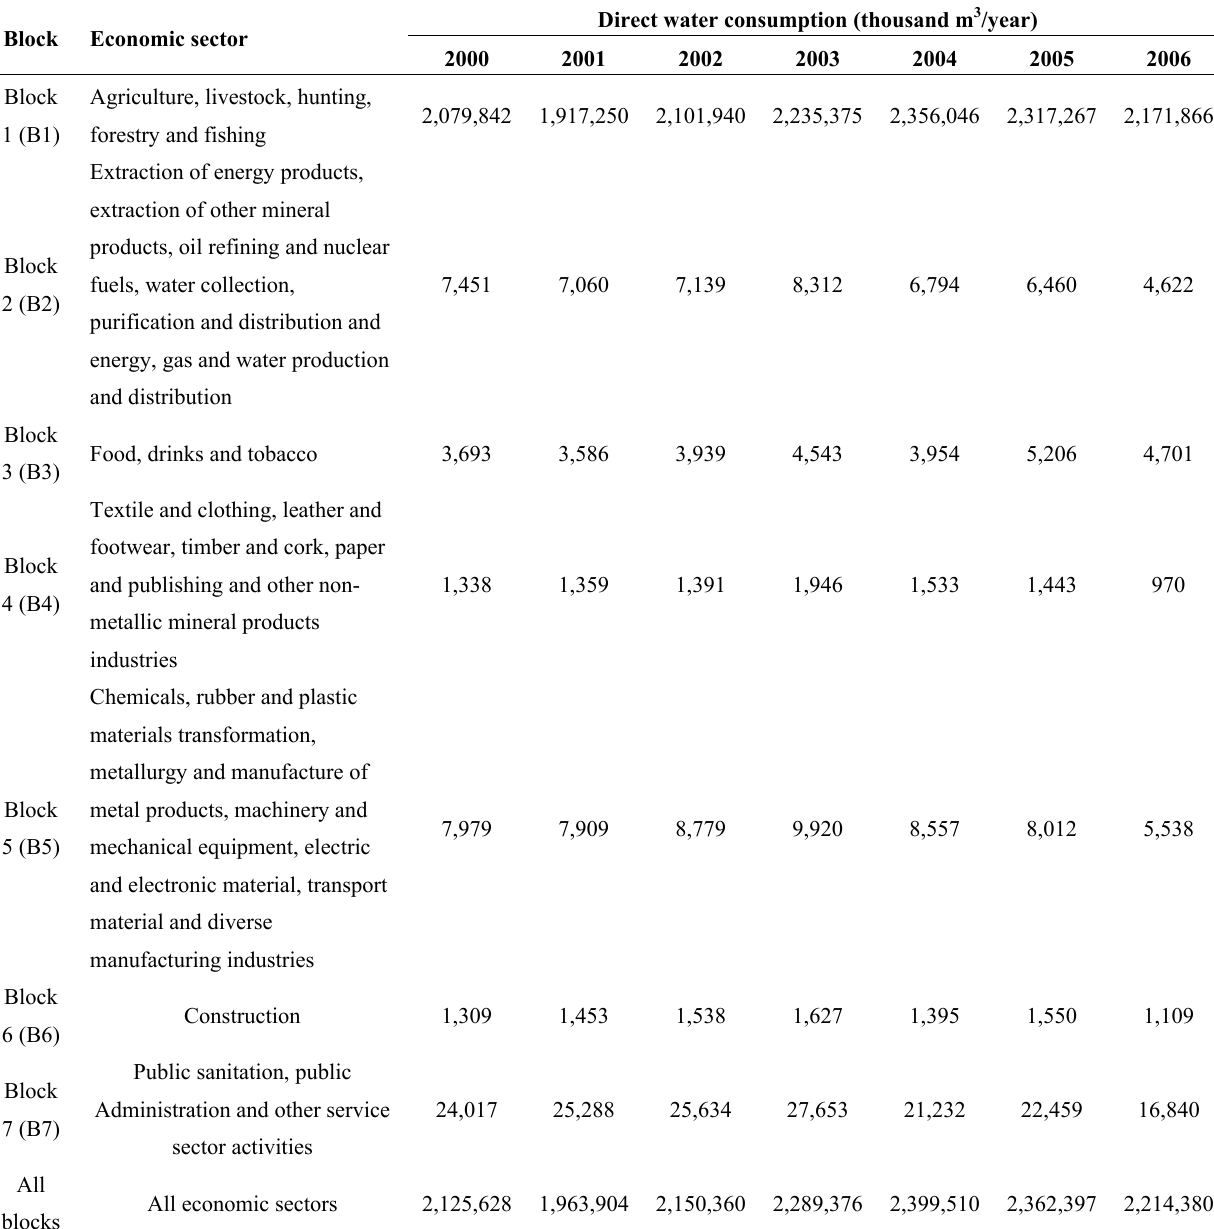
Table 1. Block configuration and water demand 1 by block in the Castile and León Region,